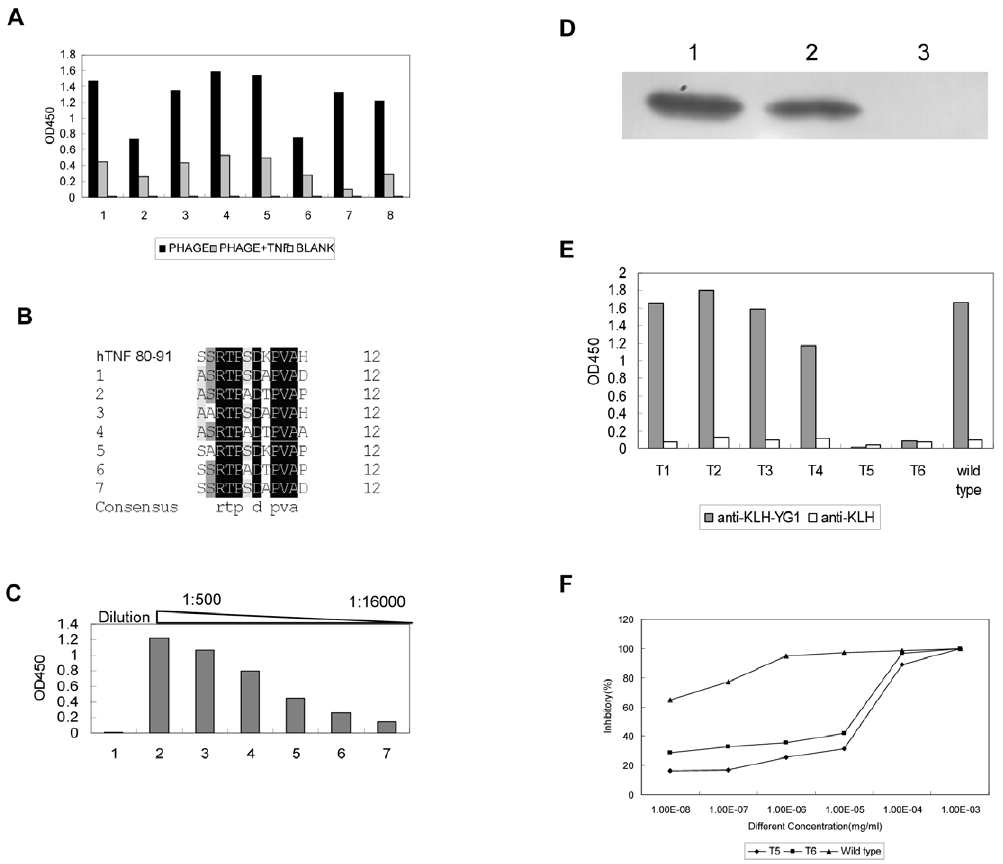
Figure 5. Identification of key amino acid in YG1. A: Specific phage clones binding to rhTNF- a antibodies were selected by ELISA and competitive ELISA. 1–8 referred to different phage clones. White bars represent negative control, black bars represent screened phage clones (1 6 10 9 ) alone, and gray bars represent screened phage clones (1 6 10 9 ) plus rhTNF- a protein (5 m g). B: Sequence similarity between binding peptides obtained by Alanine Scanning and the N terminus of rhTNF- a . The alignment of different sequences was proceeded by the software DNAMAN. 1–7 referred to different binding peptides sequences. The conserved sequence is XXRTPXDXPVAX (X means any amino acid). C: Development of anti- rhTNF- a antibodies using KLH-AP. The interaction between rhTNF- a and sera was tested by ELISA. Results are expressed as OD value at 450 nm. Group1 represents control group sera immunized with KLH, Group2–7 represent sera immunized with KLH-AP were diluted from 1:500–1:16000. D: The interaction between rhTNF- a and sera was tested by Western blot. Different antisera was diluted as 1:500. Lane1 represents antisera against rhTNF- a , and Lane2 represents antisera against KLH-AP, Lane3 represents antisera against KLH. E: The interaction between different rhTNF- a mutants and sera immunized with KLH-YG1 was tested by ELISA. The result of ELSIA was expressed as OD at 450 nm. T1, R82A; T2, T83A; T3, P84A; T4, D86A; T5, P88A and T6, V89A. The experiment was performed twice. F: Detection of the cytotoxicity induced by rhTNF- a and mutants. Serial dilutions of rhTNF- a and mutants (T5, T6) were incubated with L929 cells. The cytotoxicity was measured by detecting the amounts of cells by MTT (the triangle bar: wild type, the diamond bar:T5, the square bar: T6). The experiment was performed twice.